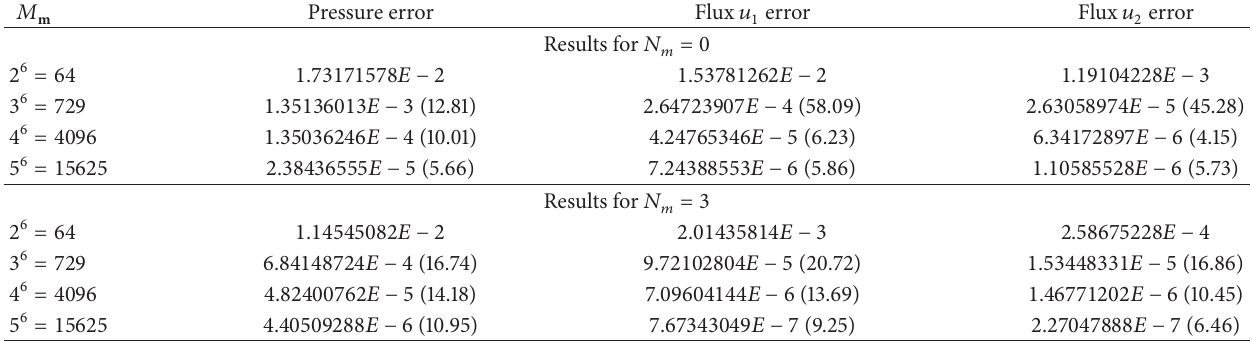
Table 3: Stochastic convergence for KL-SC method, 𝑀 max = 6 6 = 46,656. Convergence ratios are given in parentheses. 𝑀 m Pressure